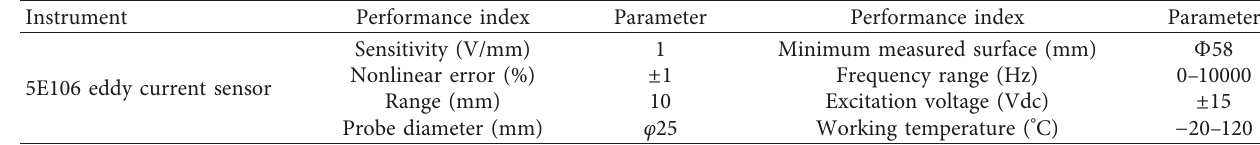
Table 1: Performance index and parameter of the 5E106 eddy current sensor.